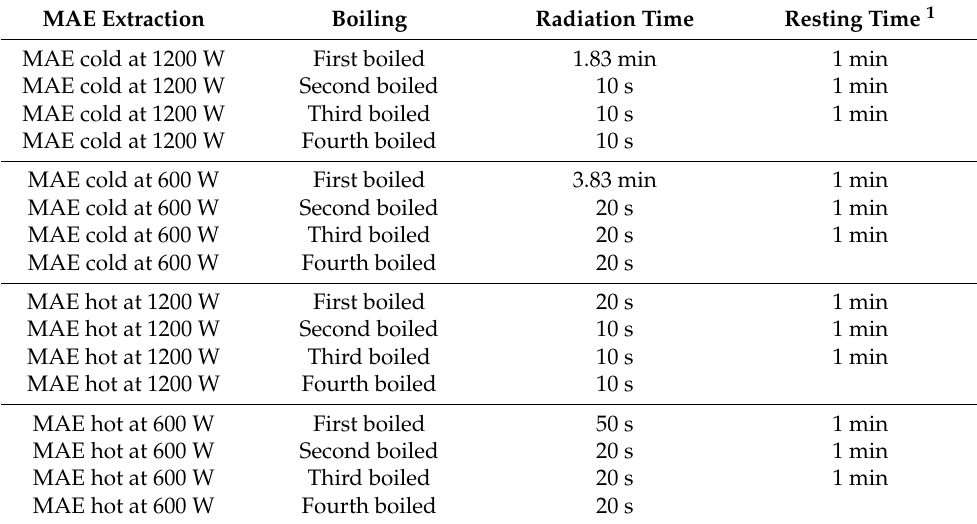
Table 1. Radiation and resting time of the MAE with hot and cold water at full and half microwave power under ambient temperature of 20 ◦